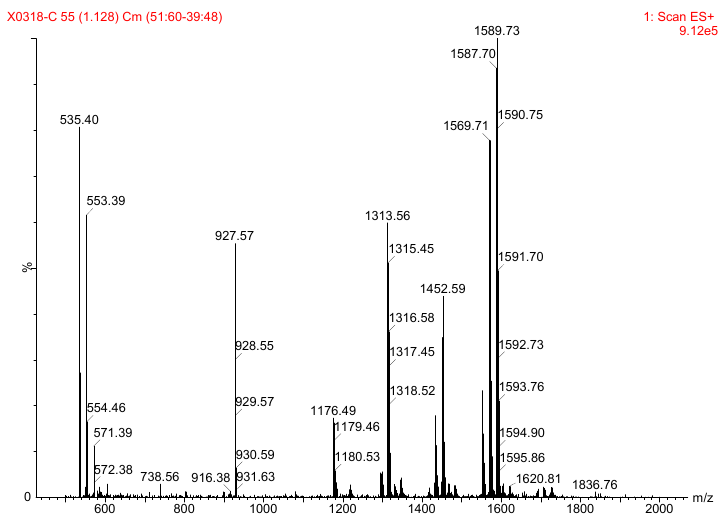
/ L2 / 1a = 0.1 / 0.11 / 2